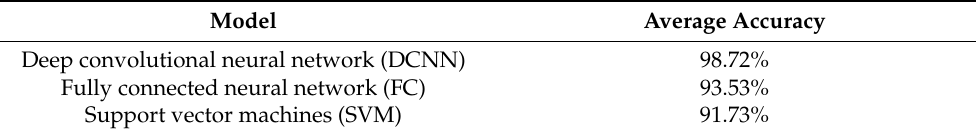
Table 8. The age accuracy of the three models’ ten-fold